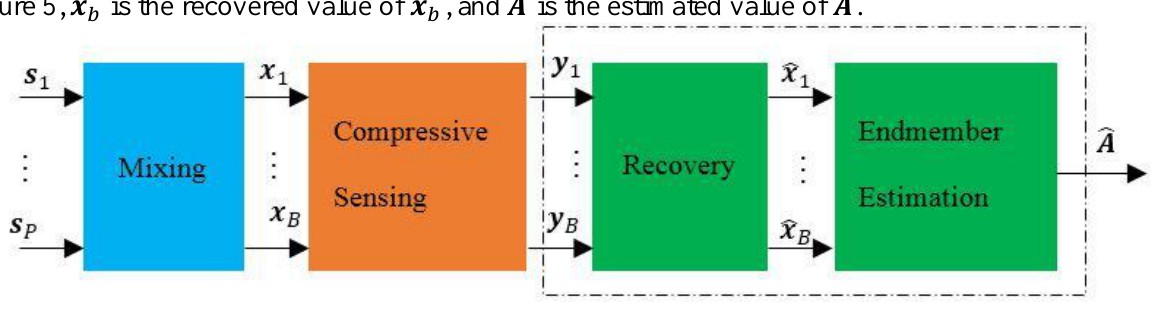
Figure 5. The framework of the traditional method based on DCS